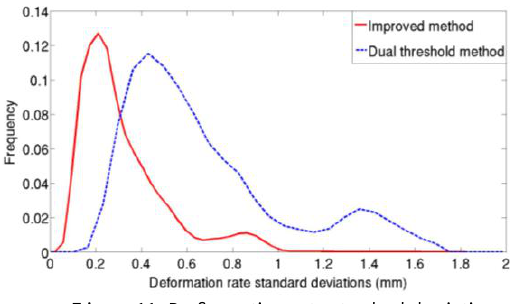
Figure 11. Deformation rate standard deviations